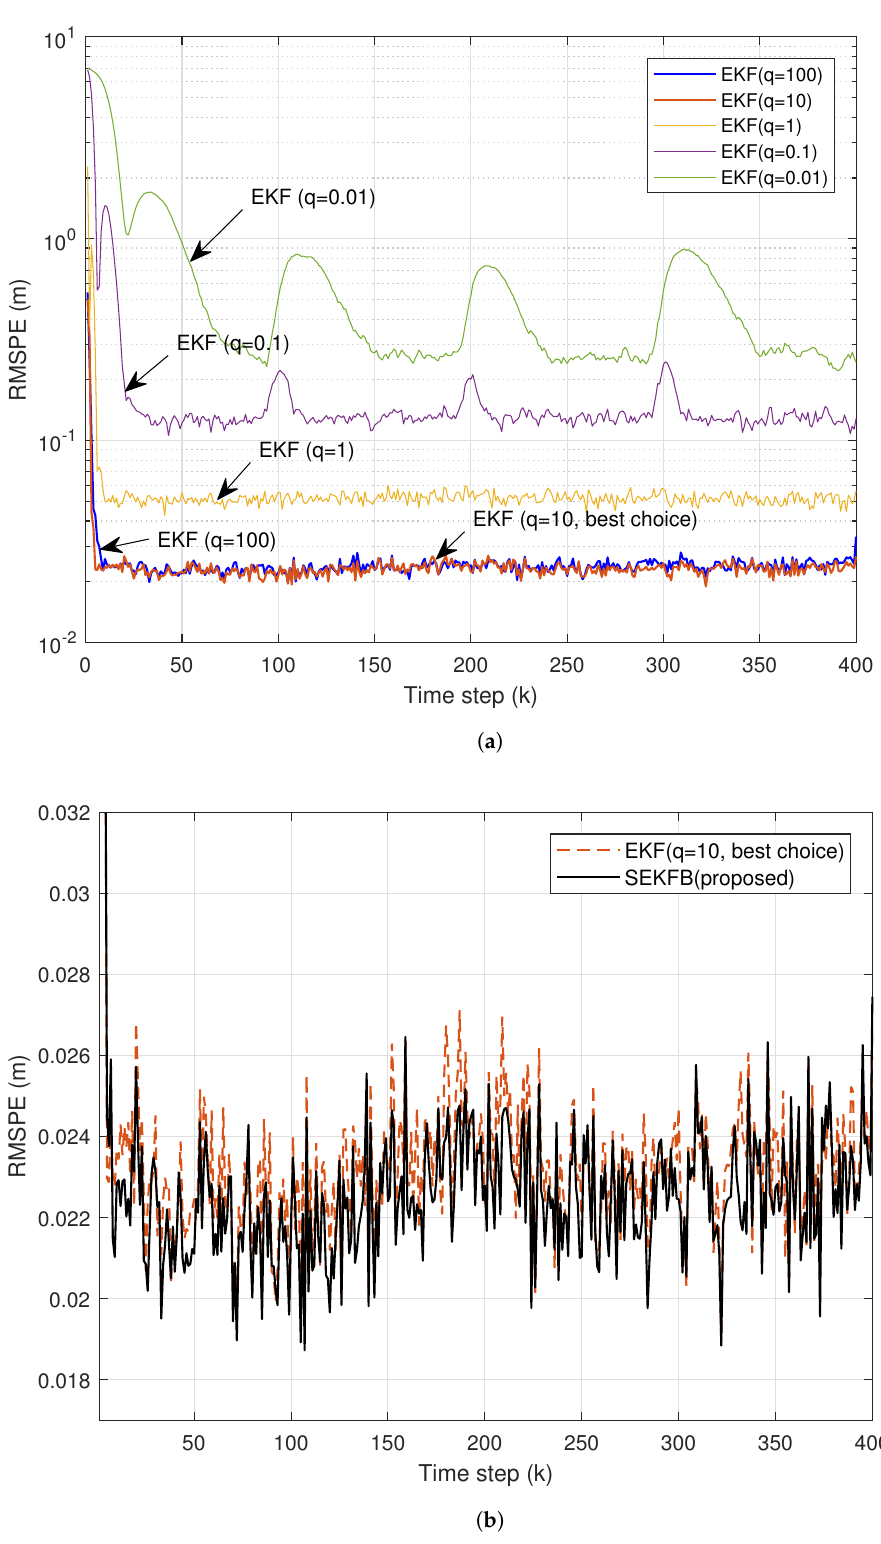
Figure 5. Root-mean-square position error (RMSPE) in localization simulation: ( a ) extended Kalman filters (EKFs) using five covariance hypotheses; ( b ) proposed filter and EKF using best